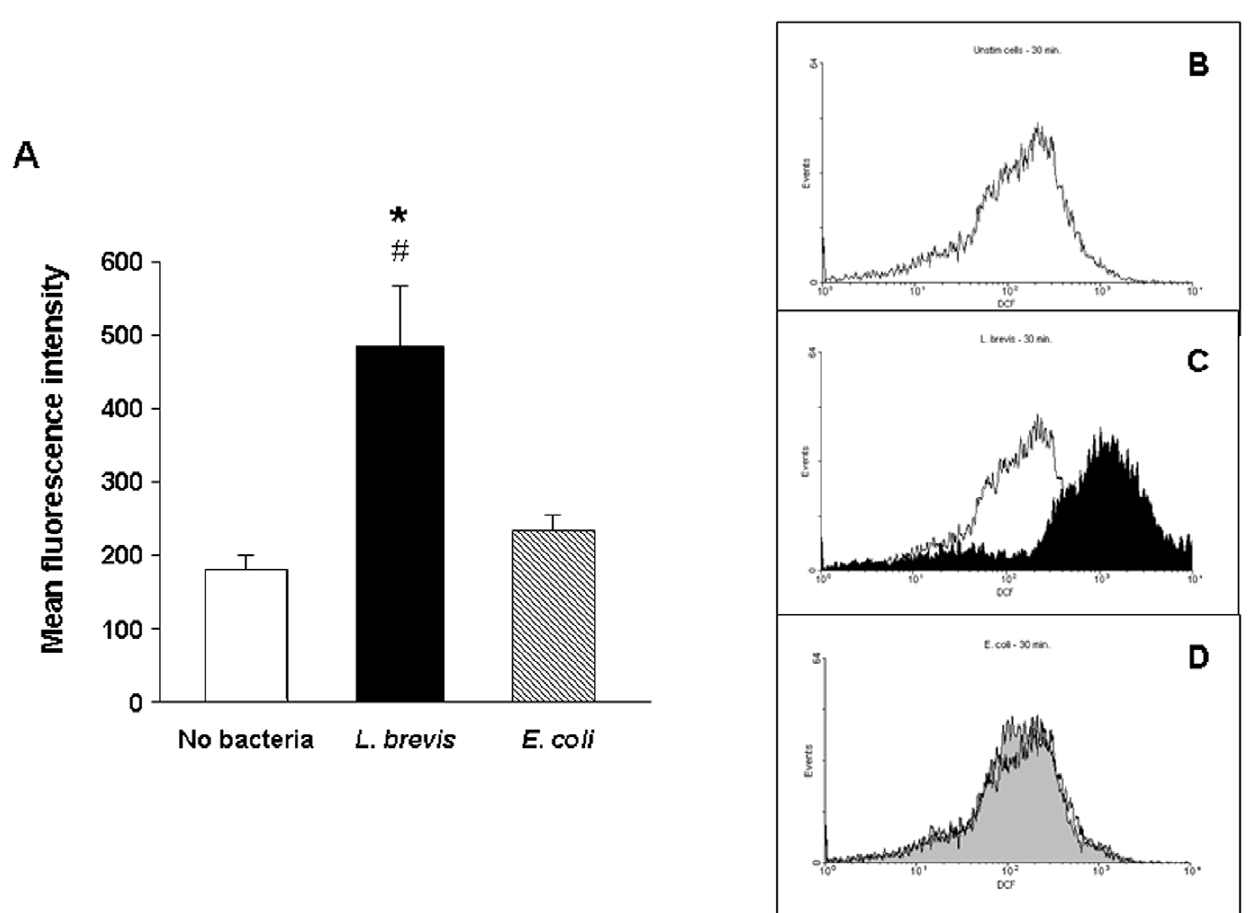
Figure 6. L.brevis -induced reactive oxygen species production by LPMC. Left panel (A): control LPMC were left alone or exposed to L. brevis or E. coli sonicates for 30 minutes, after which production of reactive oxygen species by LPMC was assessed. Data are expressed as mean fluorescence intensity of LPMC. Each bar represents 5 separate experiments. *p=0.02 vs. no bacteria; # p=0.04 vs. E. coli . Right panel: Flow cytometric analysis of control LPMC. Cells were left alone (B) or exposed to L. brevis (C) or E. coli (D) sonicates for 30 minutes, after which production of reactive oxygen species by LPMC was quantified and expressed as mean fluorescence intensity. Figures are representative of 5 separate experiments.